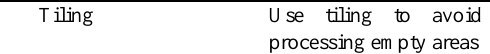
Table 4. Levers available for shortening workflow